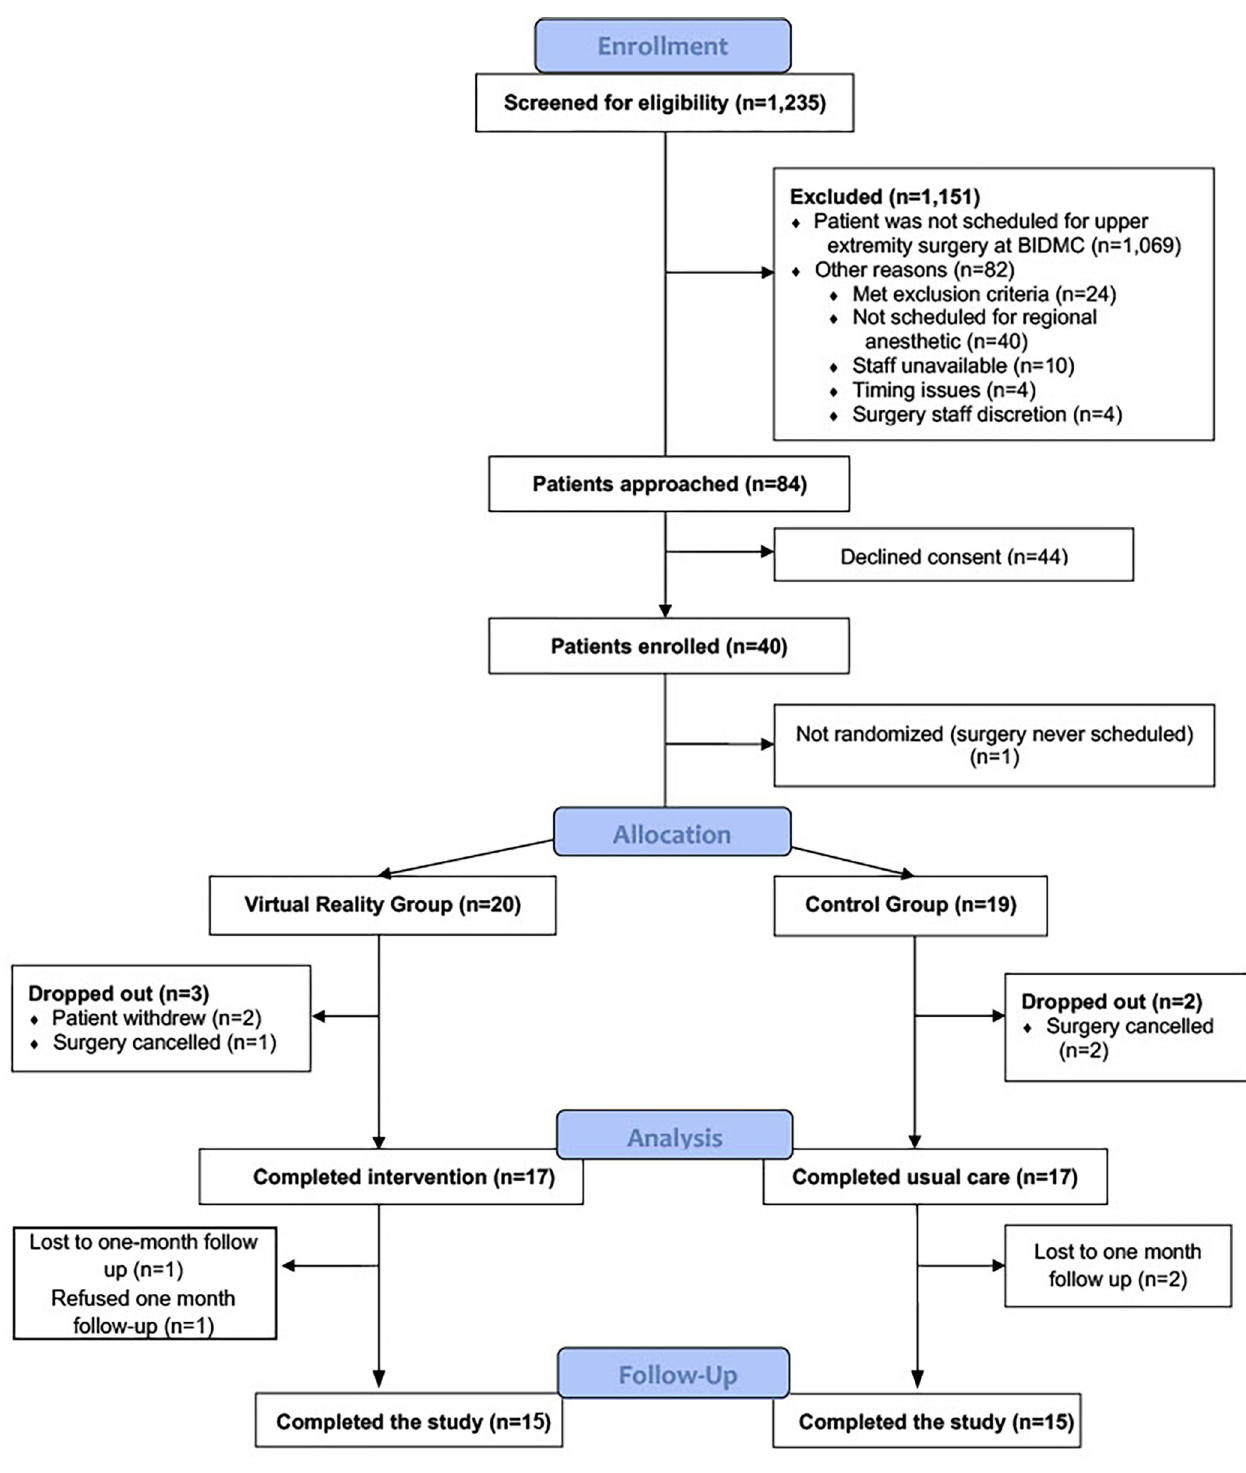
Fig 1. Consolidated Standards of Reporting Trials (CONSORT) flow diagram.